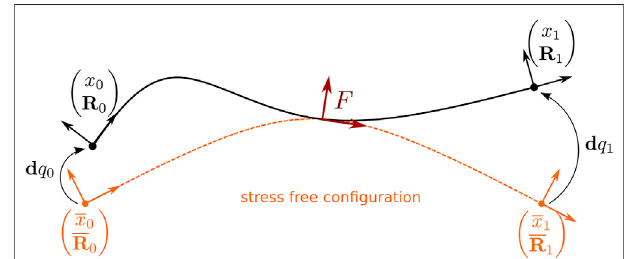
FIGURE 1 | The computation of the deformation is done in the local reference frame F of the beam element (in red). Using this frame, the 6D local displacements of the nodes are computed between the current con fi guration and their rest con fi guration (in orange).